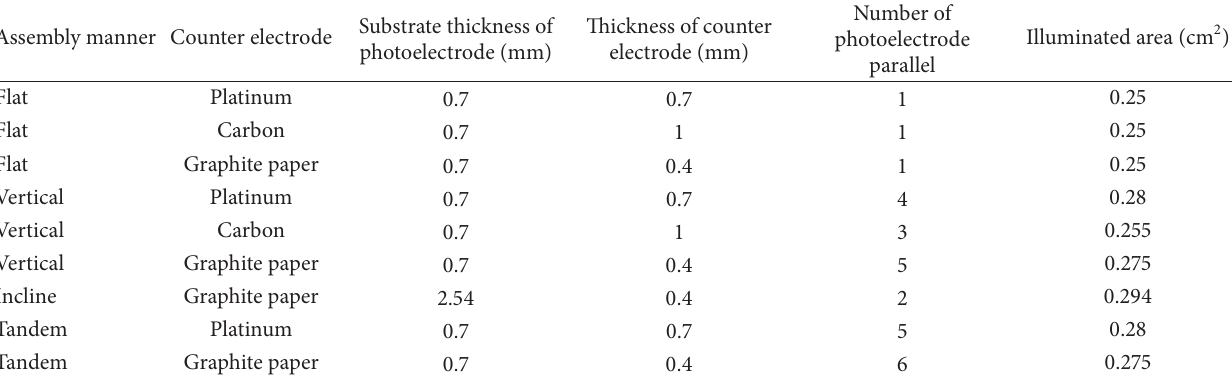
Table 1: Design dimensions of different parts of the experimental sample.